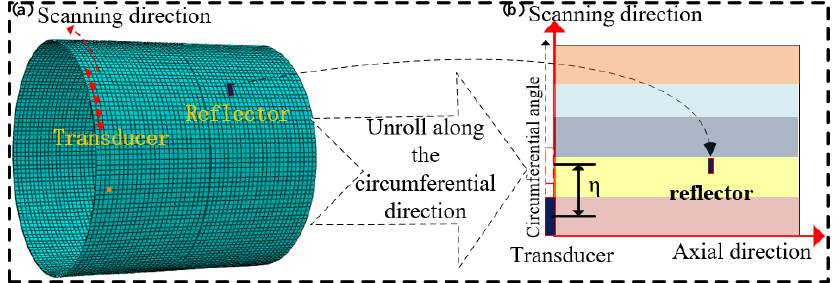
Figure 2. Schematic showing the pipe and its unrolled image by the guided-wave circumferential scanning technique: ( a ) numerical model; ( b ) circumferential scanning image.